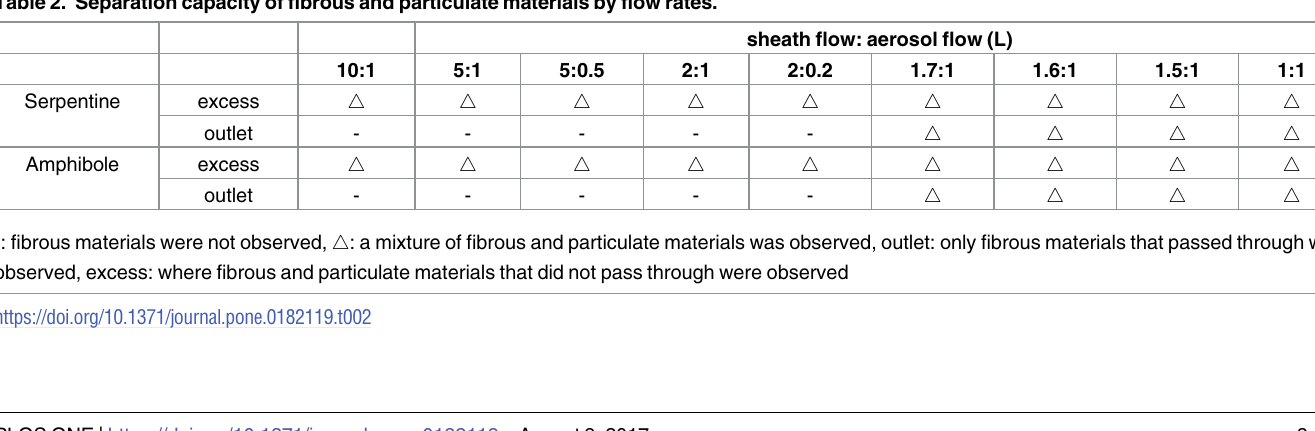
Table 2. Separation capacity of fibrous and particulate materialsby flow rates.